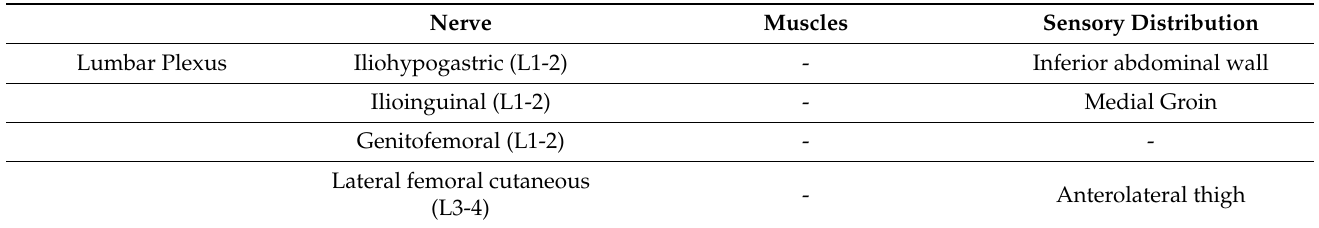
Table 1. Nerves of the lumbosacral plexus and their respective muscular and sensory innervations [20]. Nerve